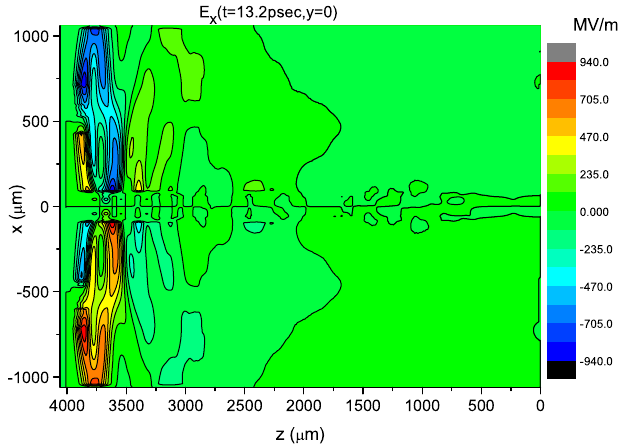
FIG. 17. (Color) Map of the transverse component of electric field along the structure for time t ¼ 13 : 2 psec . The annular drive bunch is at the left side of the map.